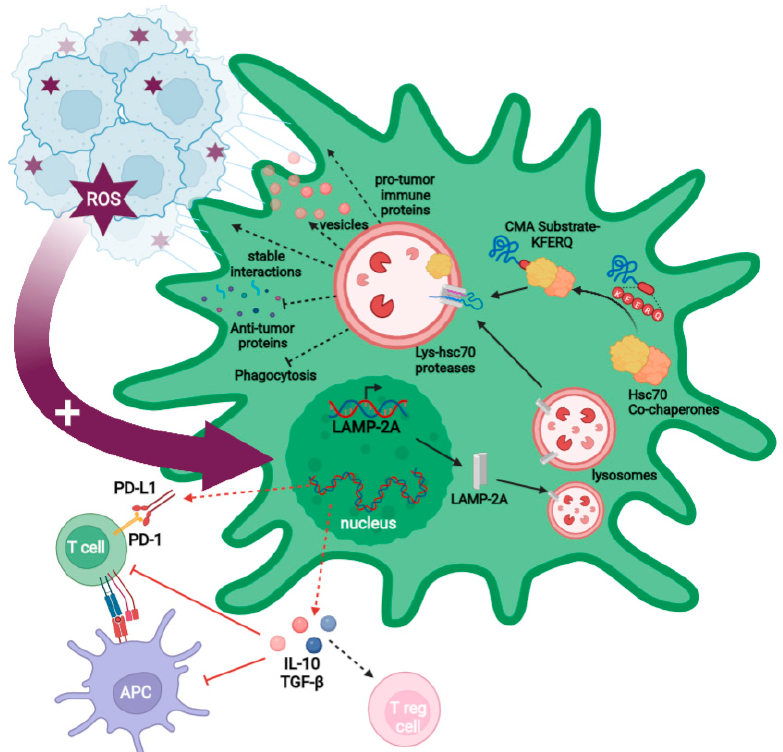
Figure 2. Model of the effects of GB-induced CMA on PCs. GB interaction with PCs promotes a ROS burst that triggers the increased upregulation of CMA in PCs through the expression of LAMP-2A (big garnet arrow). KFERQ motifs in CMA substrate proteins are recognized by the Hsc70 chaperone in a complex with other co-chaperones. This complex binds to substrates and carries them to the lysosomal membrane where they interact with LAMP-2A, and the lysosomal Hsc70 to translocate them into the lysosomal lumen to be degraded. Aberrant induction of CMA by GB leads to changes in the PC proteome, promoting an immunosuppressive function in PCs that exerts a negative regulation on T cells and antigen-presenting cells as a result of changes in gene expression programs that up-regulate the anti-inflammatory cytokines TGF- β and IL-10 (red dashed arrows). The expression of PD-L1 (negative regulator) and the lack of CD80 and CD86 (co-stimulatory molecules) promote regulatory T cell generation (red arrows). GB-induced CMA in PCs also facilitates tumor growth by stabilizing GB–PC interaction and preventing the secretion of anti-tumor proteins and phagocytic ability. In addition, it induces pro-tumor immune molecules and modulates the MSC-like properties such as the increase in the microvesicles secretion with pro-regenerative factors and cytokines that assist tumor proliferation (black dashed arrows).